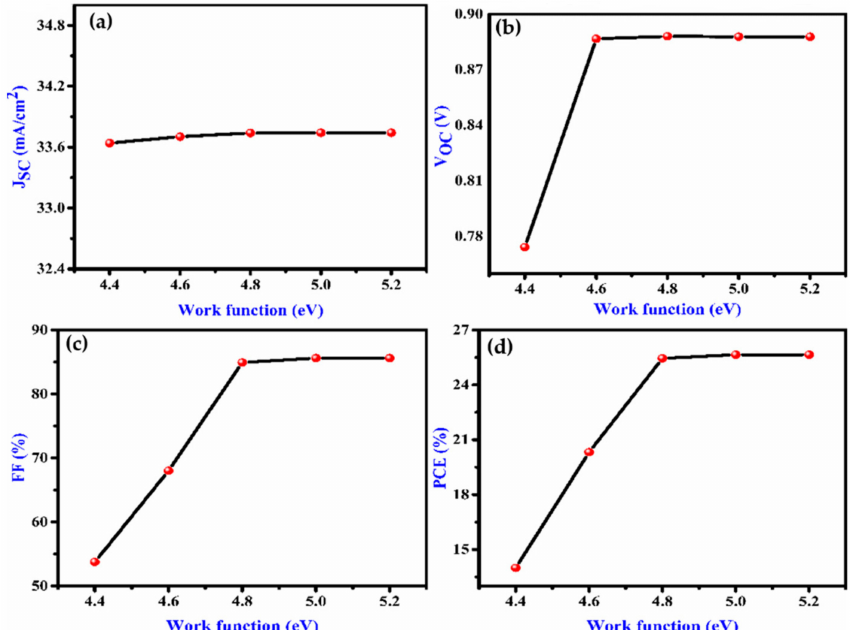
Figure 3. Effect on ( a ) J SC , ( b ), V oc ( c ) FF ( d ) and PCE with variation of work function (eV) of the proposed device.